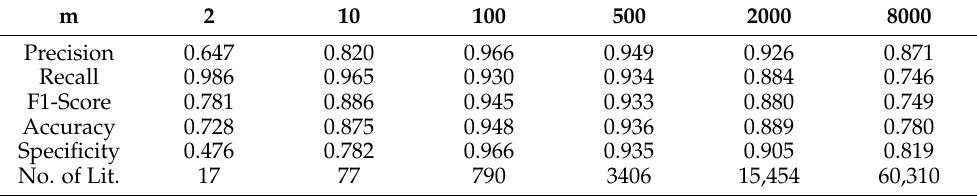
Table 11. Performance of TM with Booleanized continuous features on Balance Scale dataset.